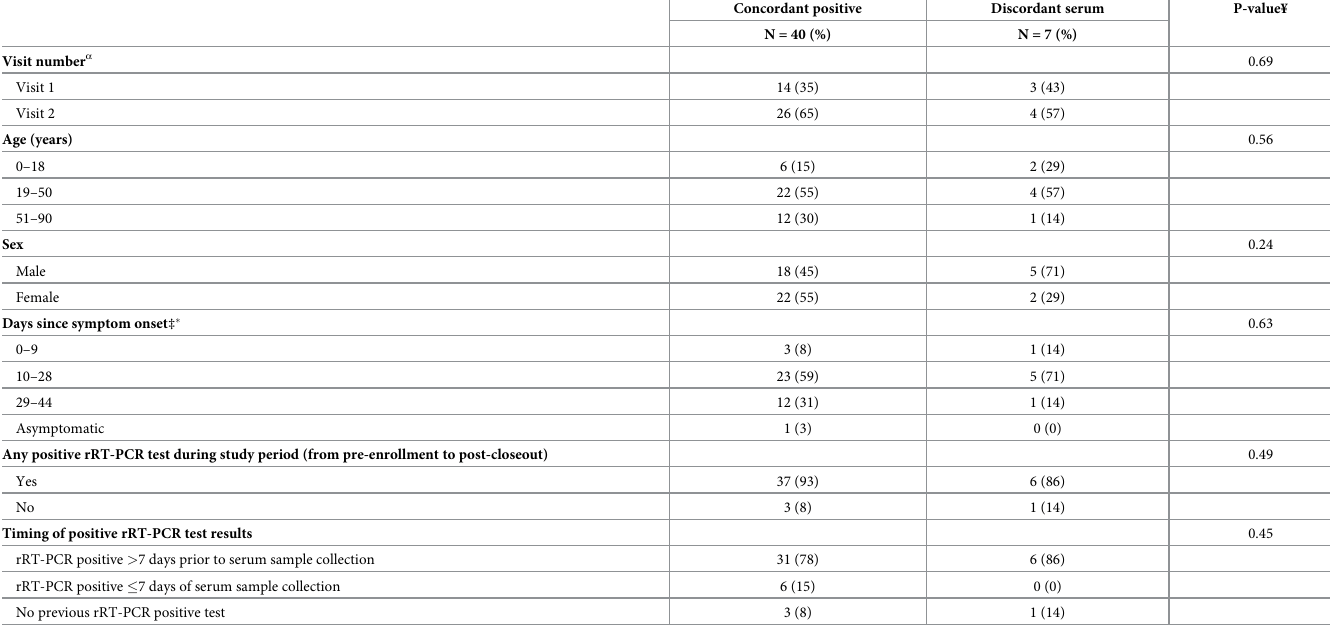
Table 1. Demographic, clinical, and laboratory characteristics of the 47 serum samples tested by both SARS-CoV-2 spike protein ELISA (spike ELISA) and Abbott Architect TM IgG assay (Architect) with at least one positive serology assay result. Concordantpositive Discordantserum P-value¥ N=40(%) N=7(%)